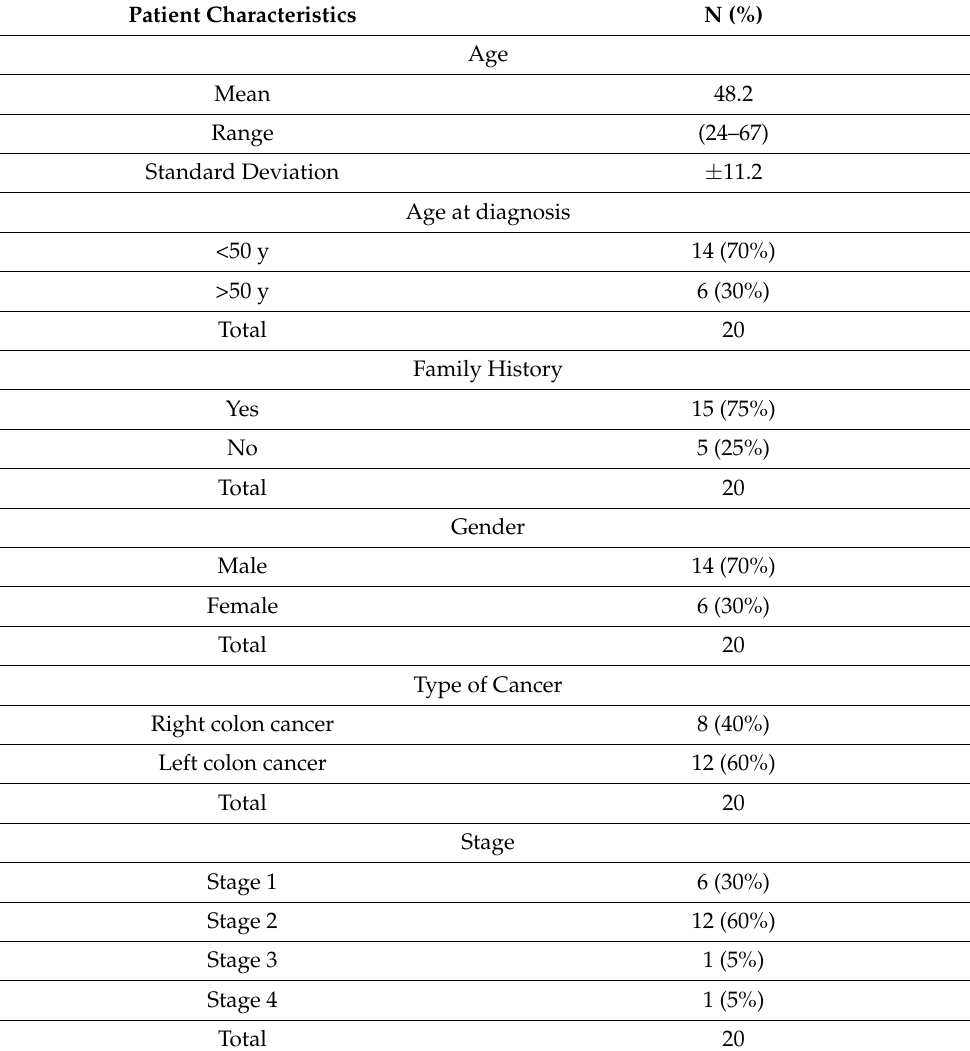
Table 1. Affected LS patients’ demographics.